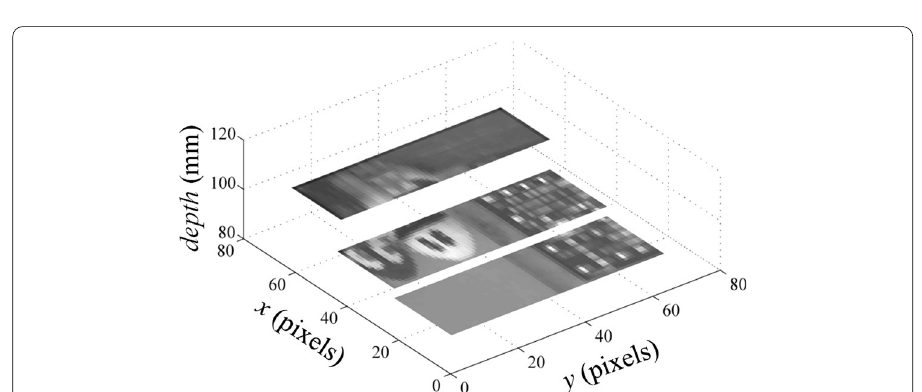
Fig. 13 Reconstructed synthetic 3D image at 570